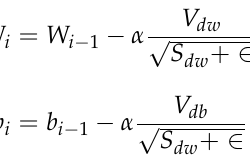
Figure 2. The architecture of the fine-tuned VGG-16 model.